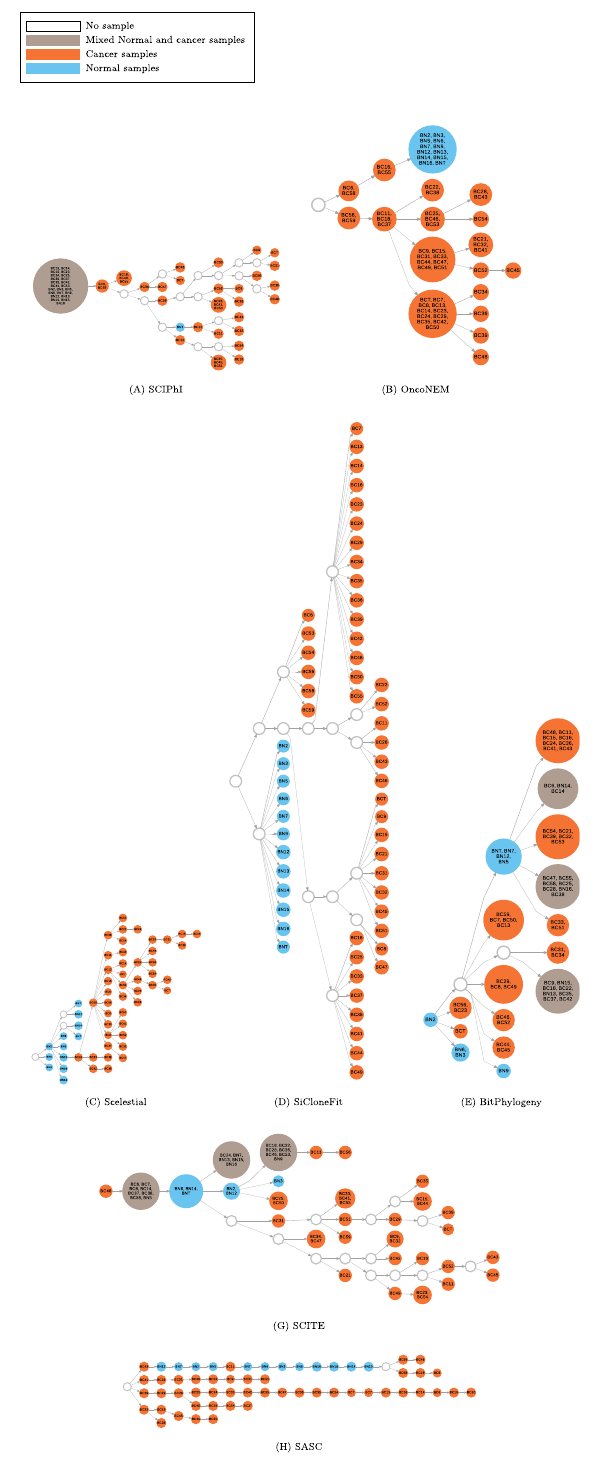
Fig 1. Lineage trees inferred by different methods on a single-cell dataset from a muscle-invasive bladder tumor. Nodes in these trees represent clones (i.e., inferred, evolutionary genomes ancestral to the observed single-cell genomes). For the methods generating trees over samples, and not the clones, colored nodes represent samples. Blue nodes represent clones containing only normal cells, orange nodes represent clones containing only cancer cells, and brown nodes represent clones containing both normal and cancer cells. Text within the nodes indicates the identification number of the assigned sample cell(s) to the corresponding clone. White nodes represent nodes with no observed